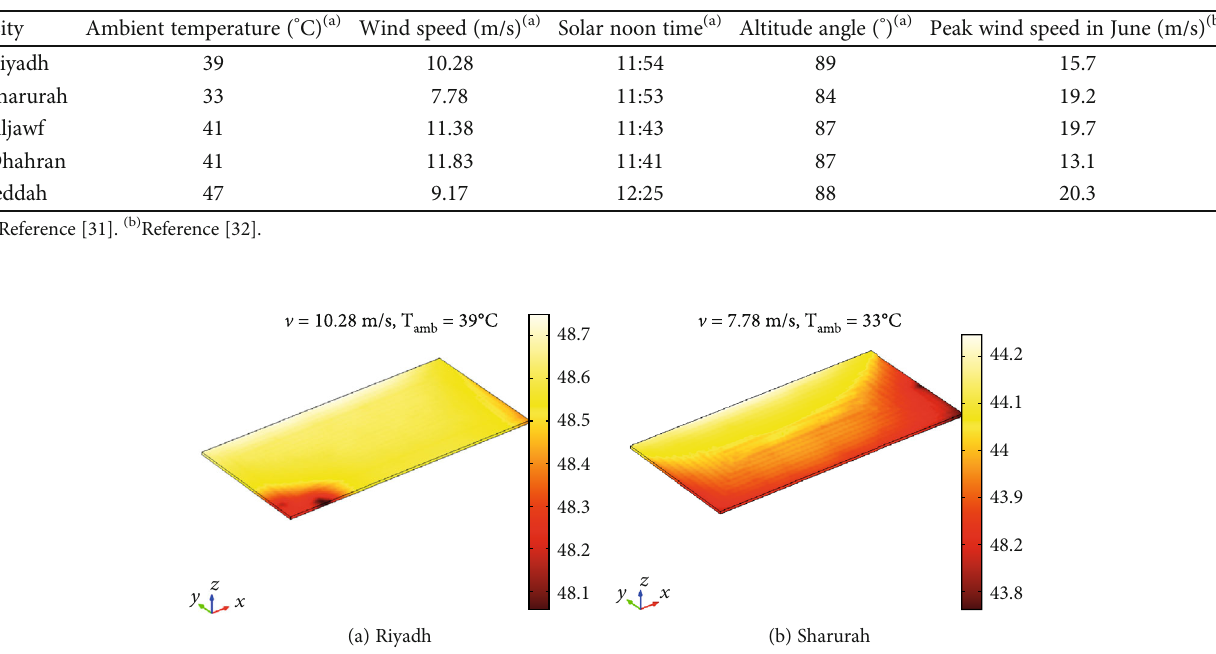
Table 1: Thermal model parameters for the geographical locations.